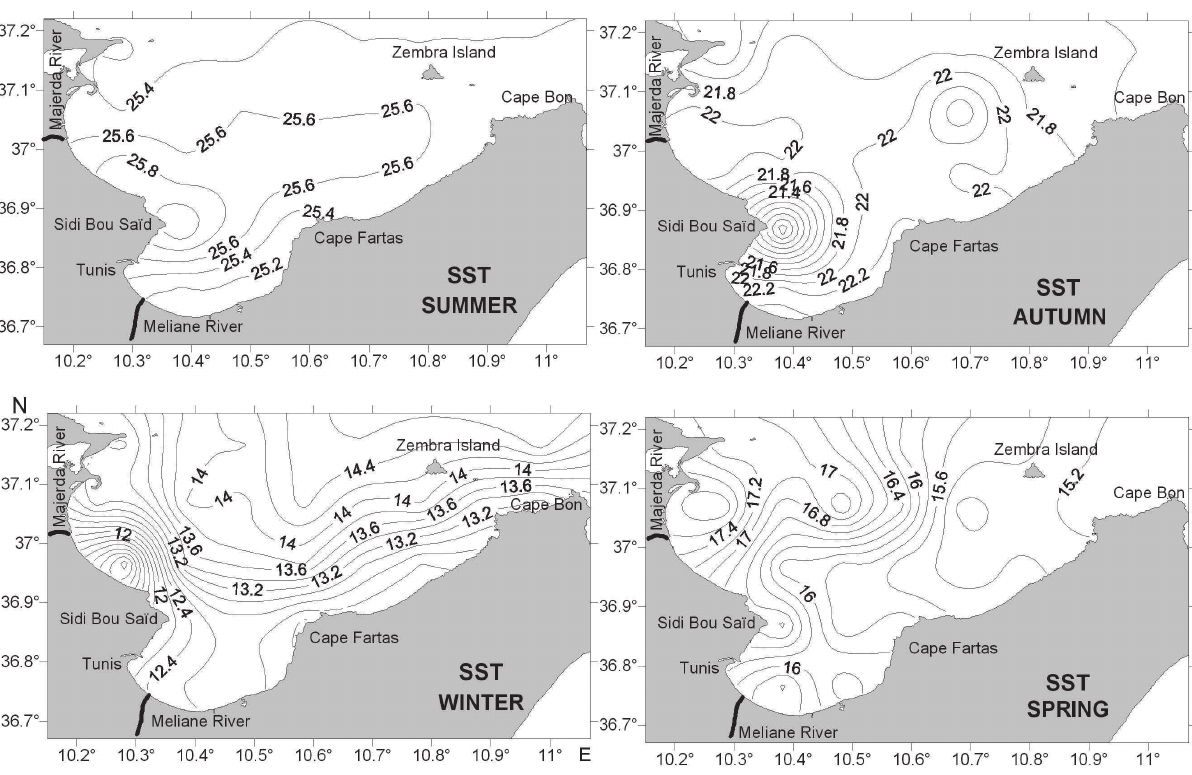
Fig. 2. – sea surface temperature (sst) maps by